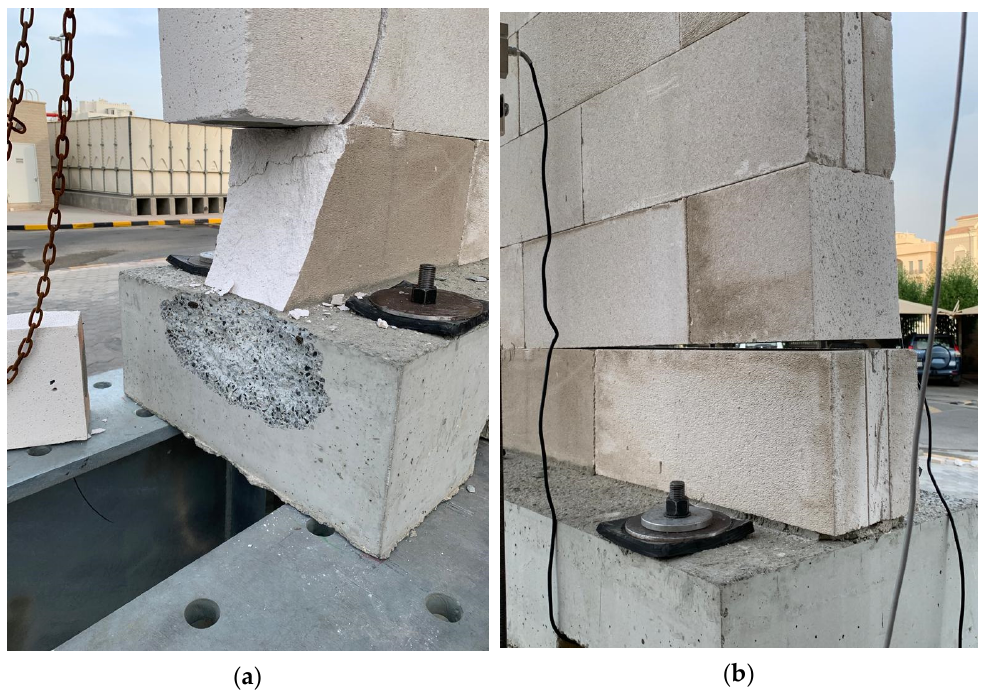
Figure 15. Failure of the unreinforced wall ( a ) on the compression side and ( b ) on the tension side.